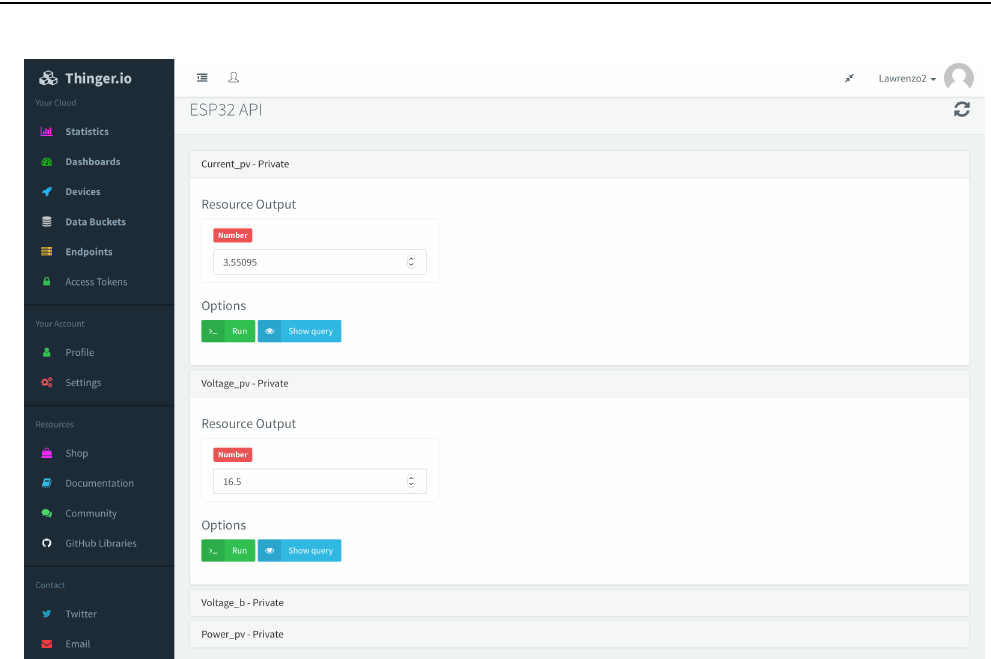
Figure 8. Thinger.IO received data